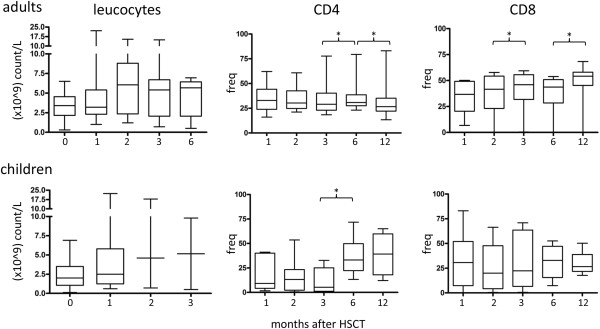
Immune reconstitution measured as absolute leukocyte counts (left figures) and CD4 and CD8 T-cell frequency after HSCT in blood from adults and children. * = p < 0.05. Note that leukocyte counts were available from children at the time of transplantation (0) and 1–3 months after HSCT.